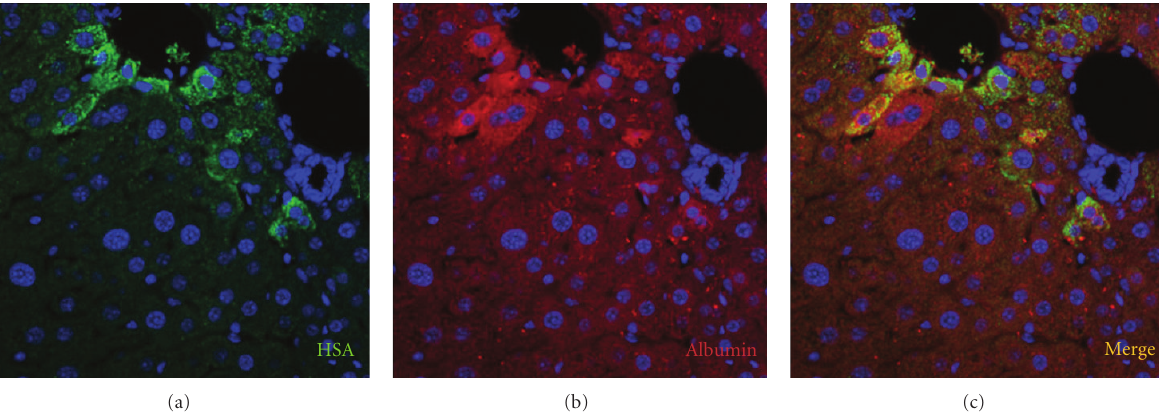
Figure 3: Transplantation of human SGP cells into the hepatectomized liver. RAG − / − mice (4 to 6 weeks old) served as recipients for cell transplantation into the liver. Mice were hepatectomized under anesthesia according to the methods described by Higgins and Anderson immediately before cell transplantation. Cultured human SGP cells (approximately 4 . 0 × 10 4 cells/ μ L) were suspended in